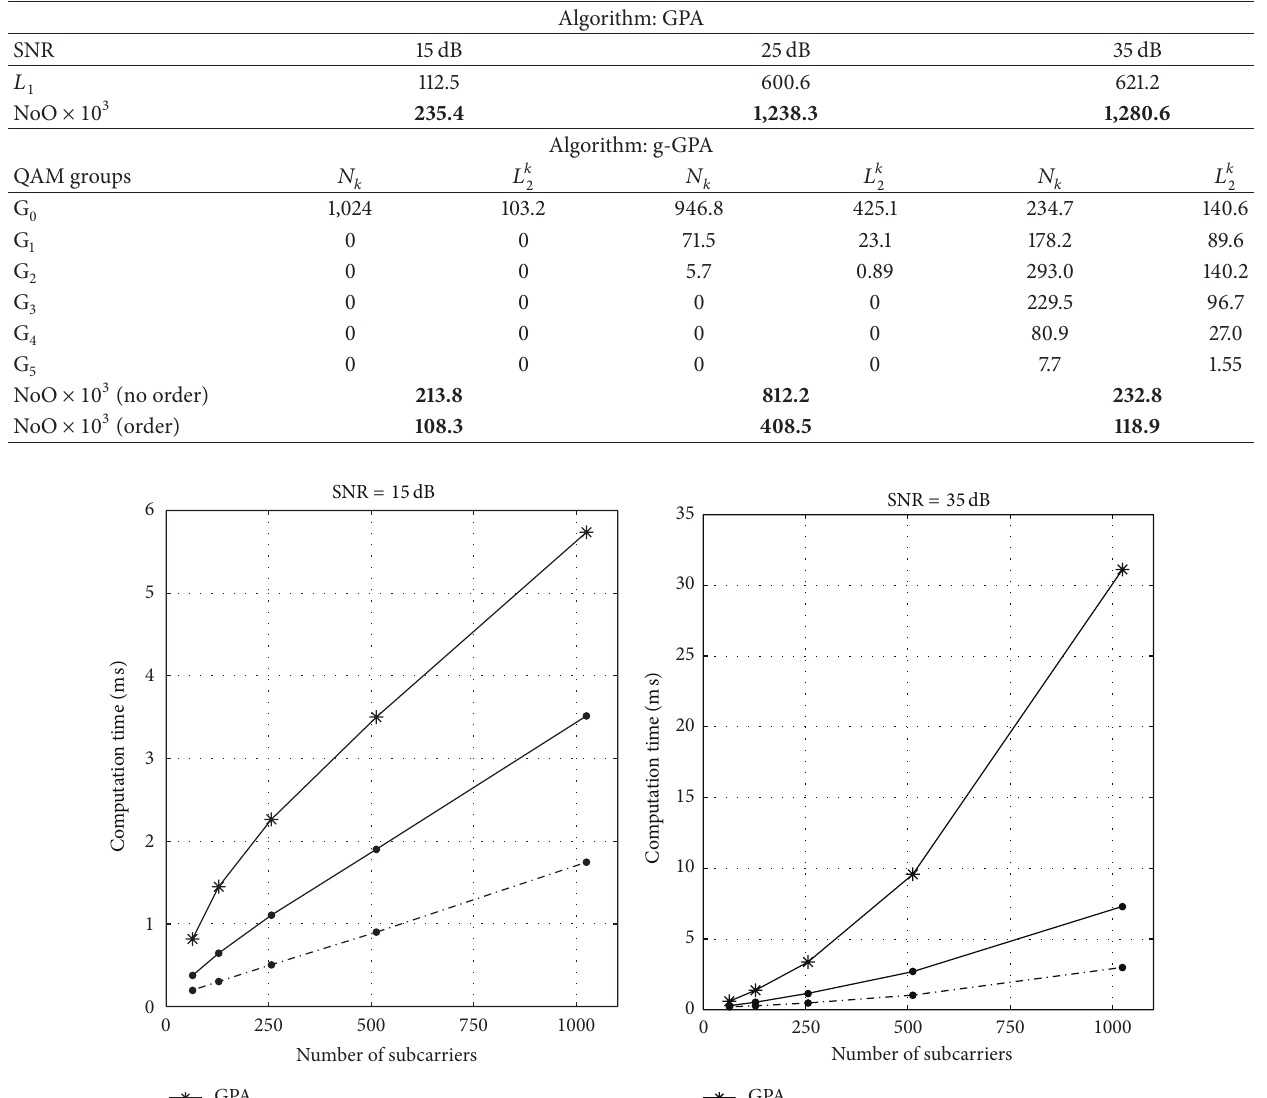
Figure 8: Average computation time comparison of the g-GPA and the GPA algorithms for P target at different SNR applications for (a) 15dB SNR and (b) 35 dB